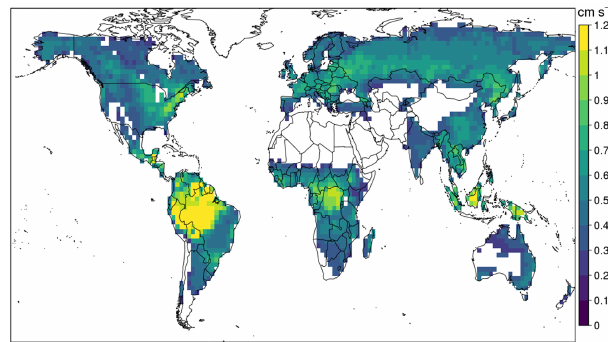
Figure 2. The 1982–2011 July mean daytime v d (solar elevation angle>20 ◦ ) over vegetated land surface simulated by